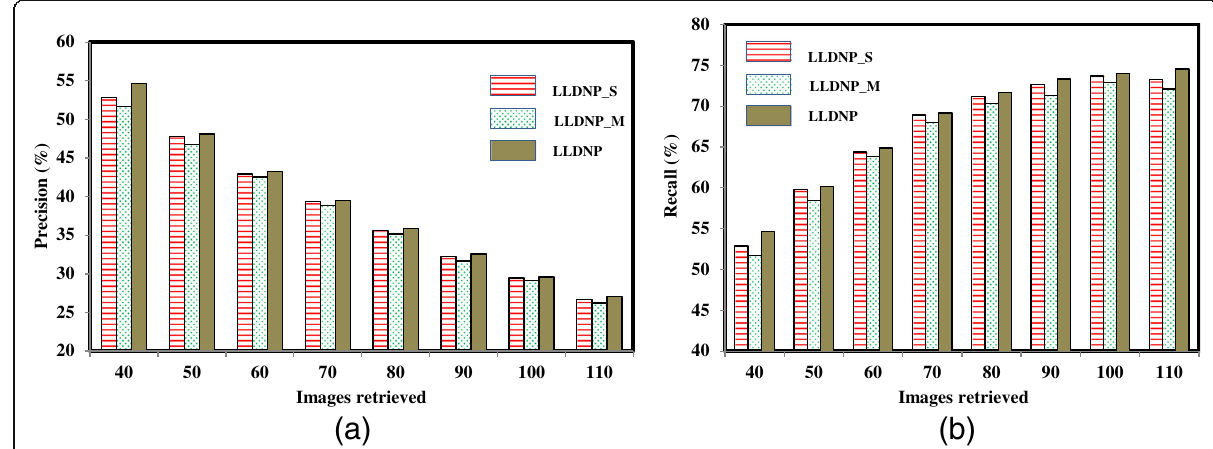
Fig. 15 Comparison of LLDNP_S, LLDNP_M, and LLDNP in terms of a precision and b recall on UIUC database. The performance of LLDNP_S is better than LLDNP_M. But LLDNP shows higher performance than LLDNP_S and LLDNP_M in terms of precision and recall on UIUC